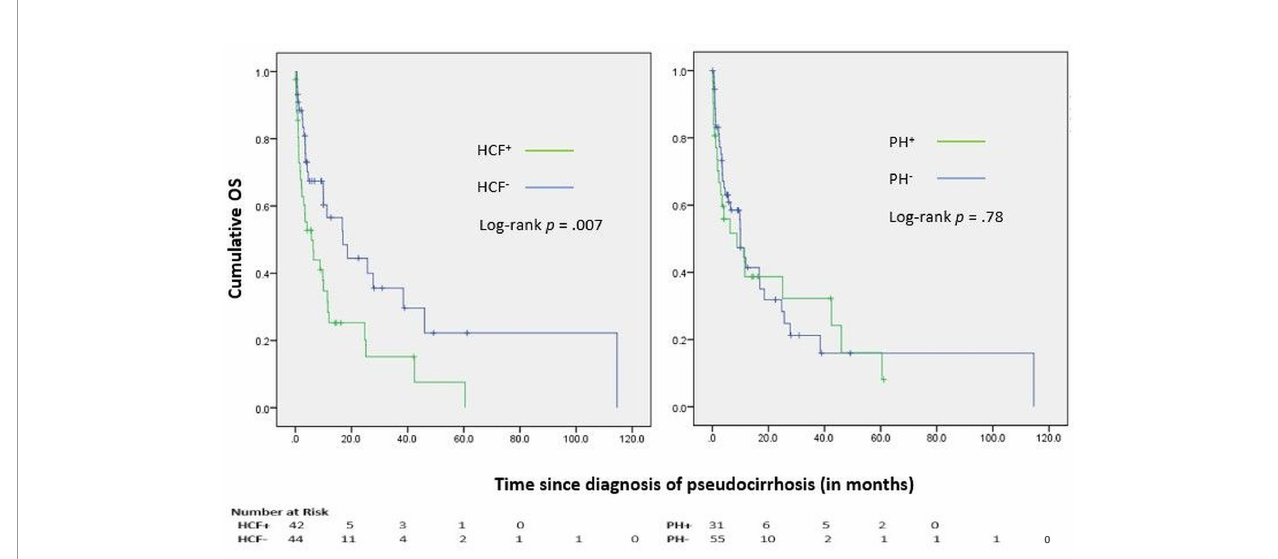
FIGURE 3 | Kaplan-Meier curves for Overall Survival (OS); HCF, Hepatocellular failure; PH, Portal